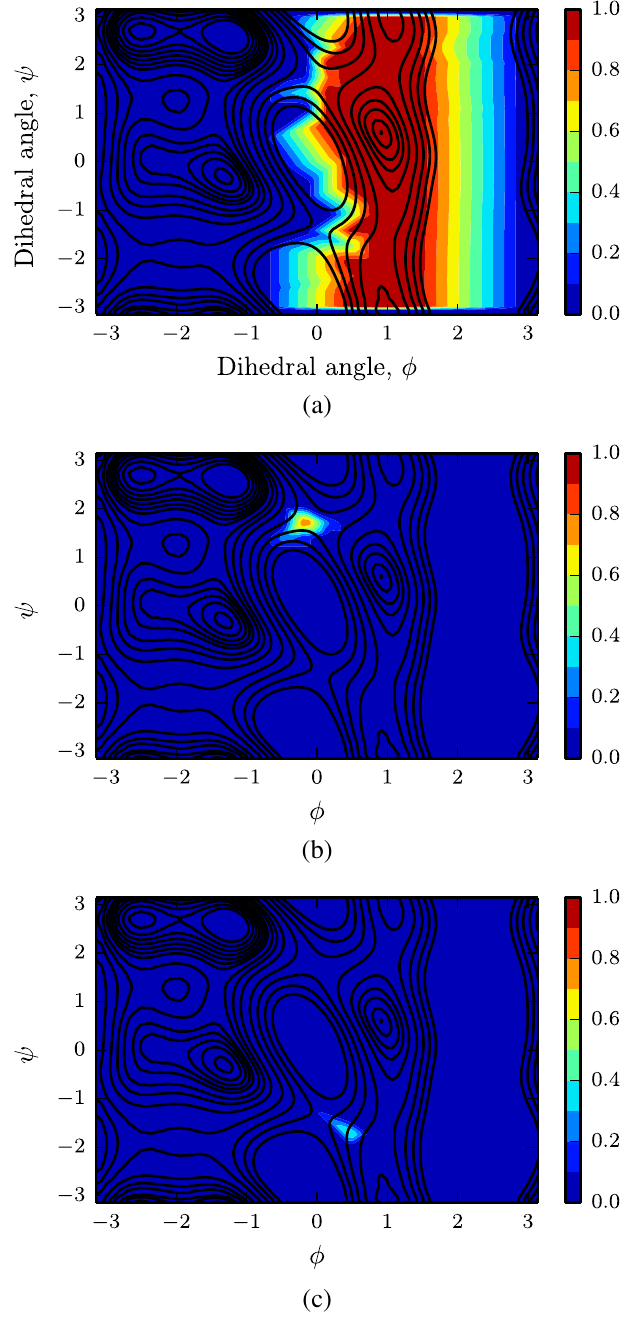
FIG. 7. Forward committor q þ ð x Þ for transition from C 5 to α L region. (a) Nonreversible reference estimate for N ¼ 10 μ s of simulation data. Dark contour lines indicate the free-energy profile. (b) Difference between the reference estimate and a nonreversible estimate for N ¼ 1 μ s of simulation data. There is a large error in the transition region due to insufficient sampling in the short simulation. (c) Distance for an estimate using a combination of umbrella sampling and standard simulation data with N ¼ N π þ N C ¼ 960 ns. There is no significant error in the transition region; the small error close to the second saddle is probably due to insufficient sampling of this region by the reference simulation.